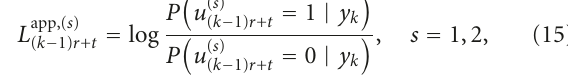
obtained for both side decoders. The WZC scheme is a single description coding scheme where the sequence of quantized values of X is directly encoded by a turbo